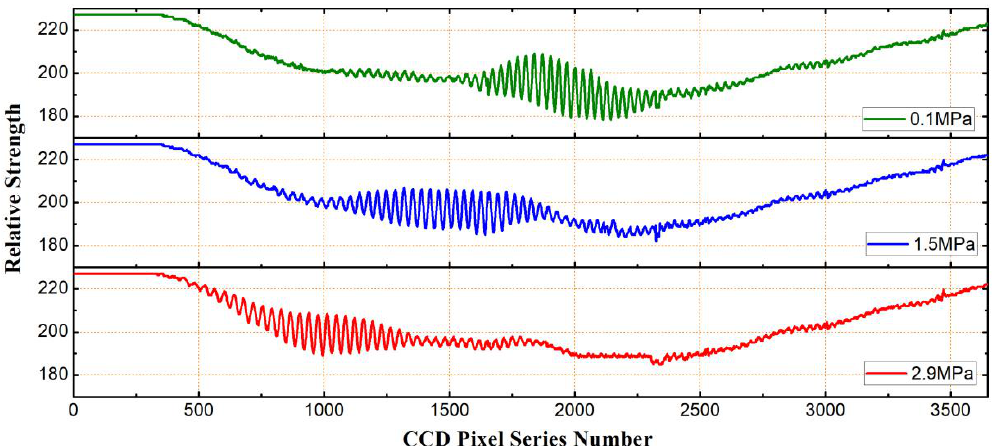
Figure 8. Correlation interferometric signals at three different pressures of 0.1 MPa, 1.5 MPa, and 2.9 MPa.